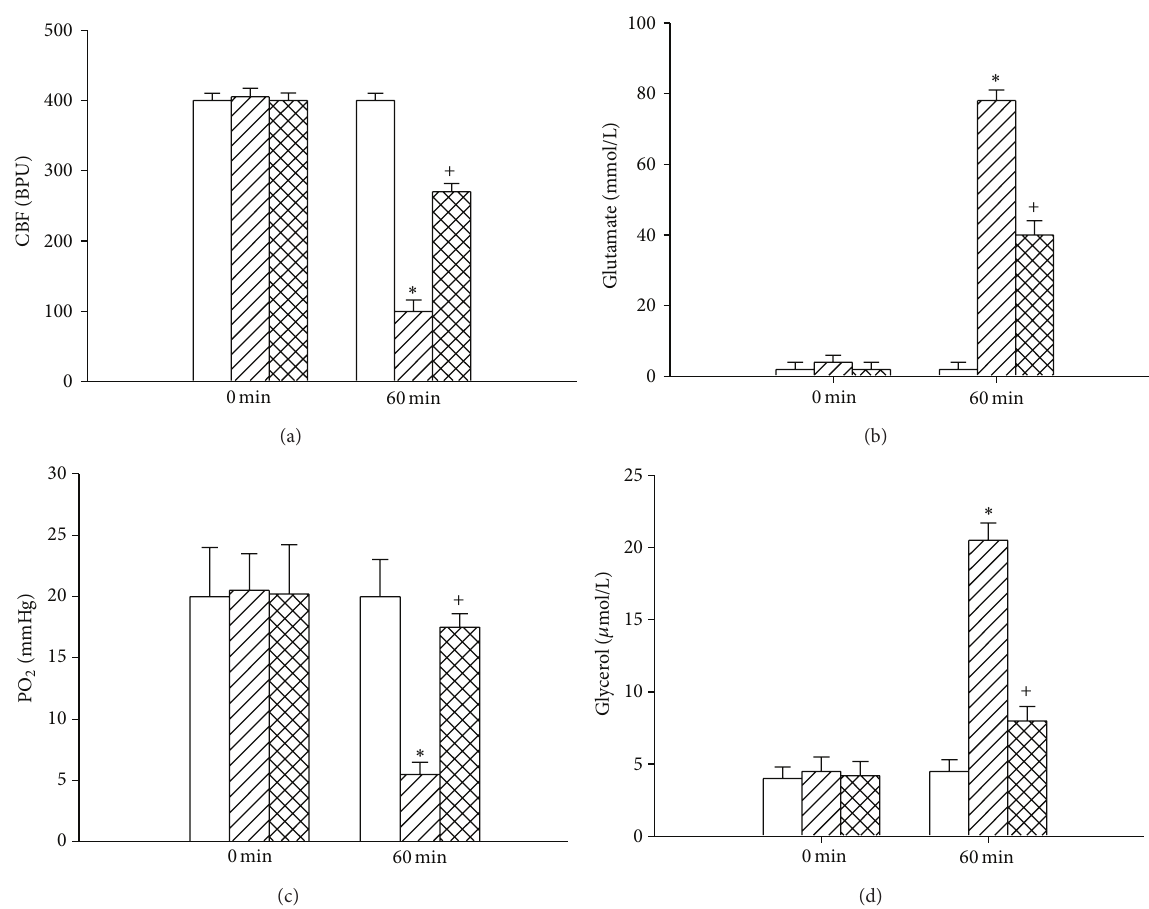
Figure 2: Values of hypothalamic cerebral blood flow (CBF), brain partial pressure of O 2 (PO 2 ), and cellular levels of glutamate and glycerol for the (NTDR + V) group (white bar), (HSDR + V) group (dashed bar), and (HSDR + H) group (crossed bar). The values were obtained at 0 or 60 min after the initiation of heat exposure in heatstroke rats or the equivalent times in the (NTDR + V) group. ∗ 𝑃 < 0.01 in comparison withthe(whitebar)group; + + 𝑃 < 0.05 incomparisonwiththe(dashedbar)group. Allheatstrokegroupshadheatexposure(43 ∘ C)withdrawn exactly at 60min and were then allowed to recover at room temperature (26 ∘ C). Bars were the mean ± SD of eight rats for each group. Please see the legends of Figure 1 for explanation of the abbreviations.